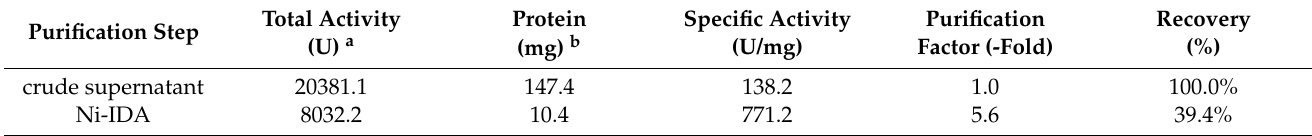
Table 1. Summary of the recombinant β -D-fructofuranosidase (AlFFase3) expressed in E. coli